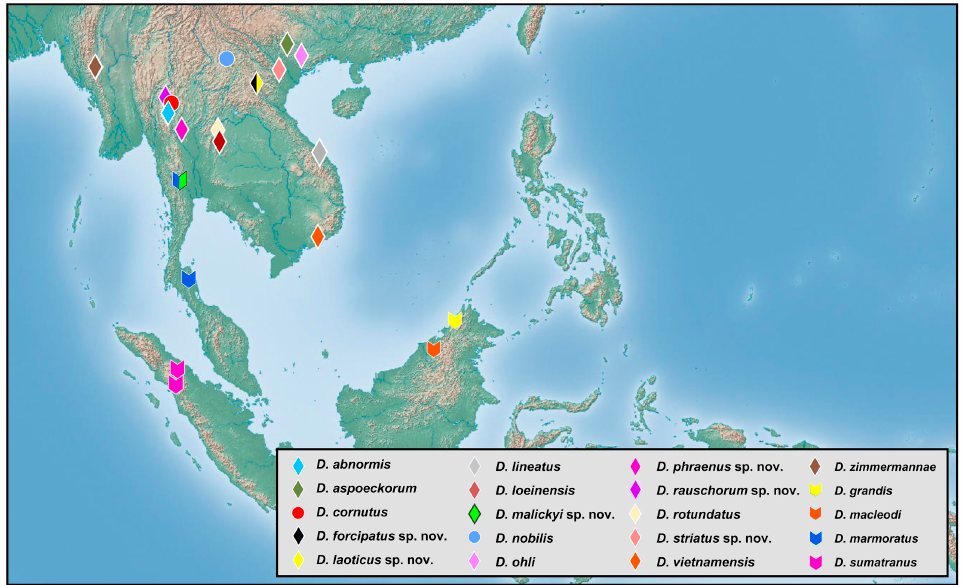
Figure 26. Distribution map of the species of Dilar from Indochina Peninsula (Region 7 in Figure 19) and Indo-Malaysia (Region 8 in Figure 19).